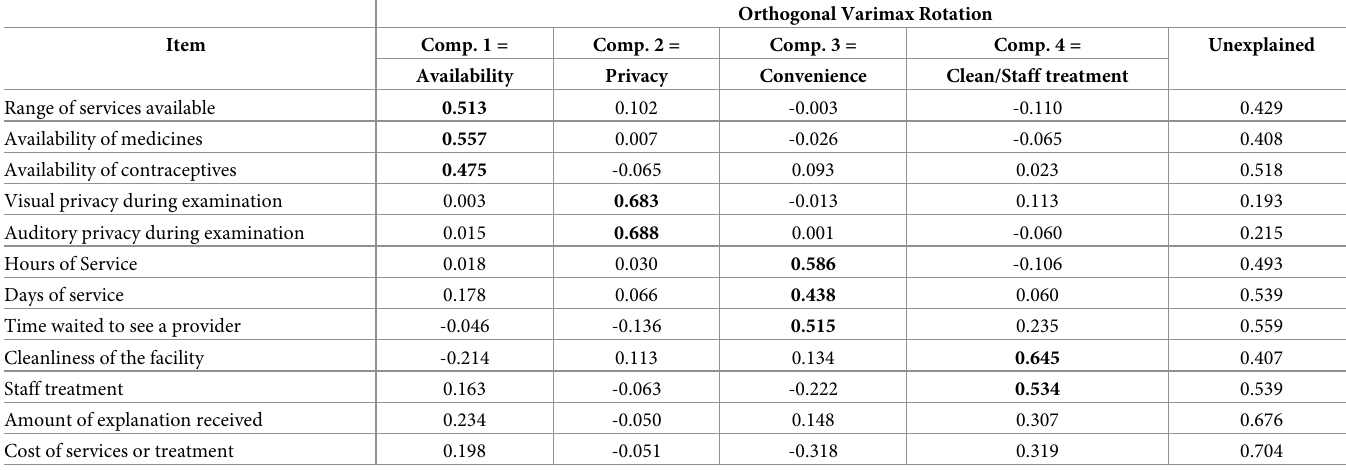
Table 1. Principal component analysis (PCA), component loadings, orthogonal varimax rotation of loading matrix after